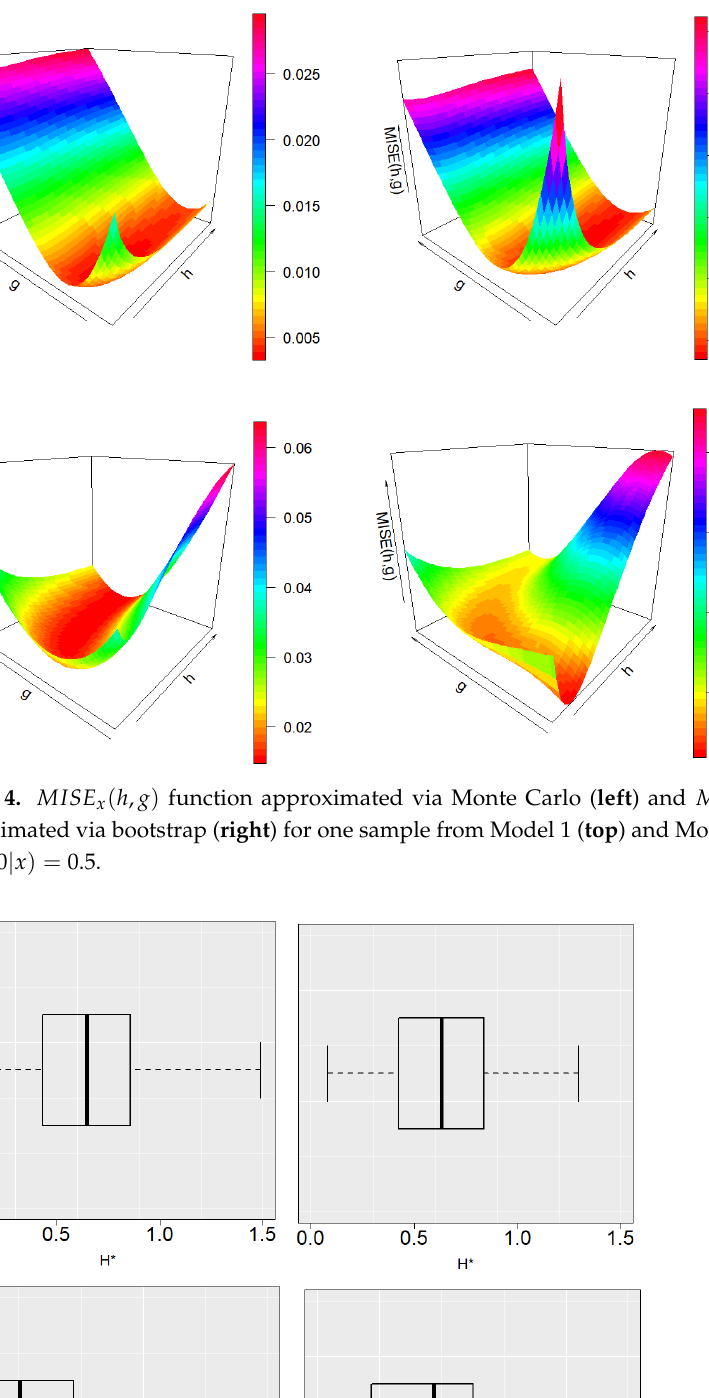
,..., H ∗ values ( top ) and boxplot of R ∗ N 1